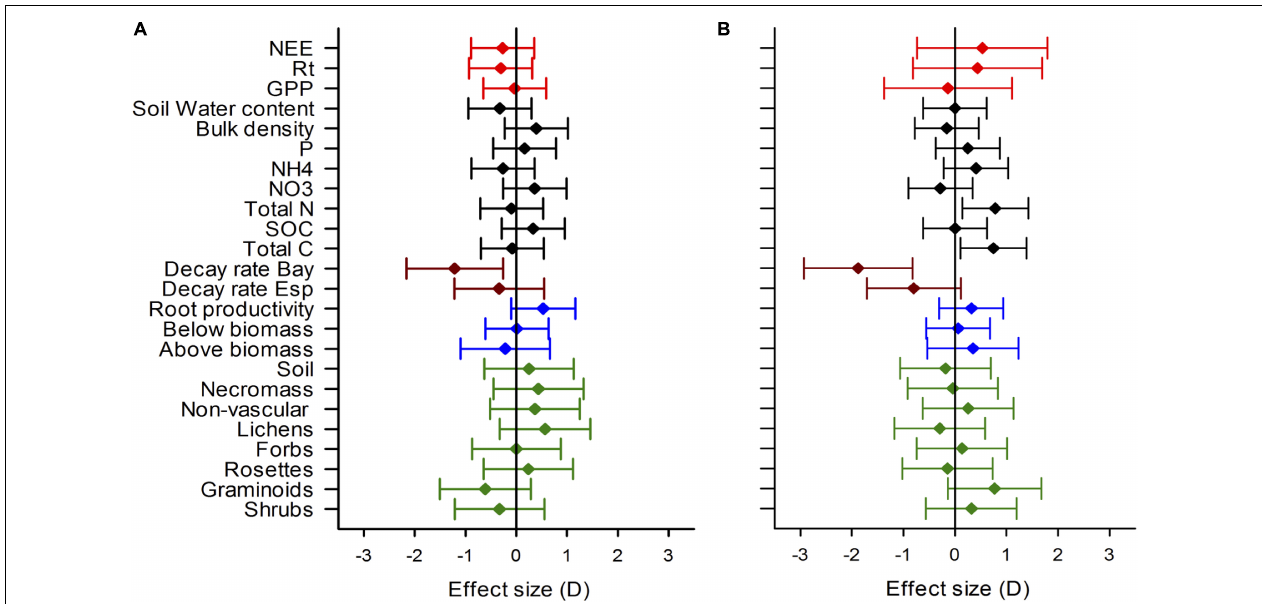
FIGURE 8 | Effects size of experimental warming on CO 2 fluxes (red symbols), soil related properties (black symbols), decomposition rate (brown symbols), productivity and biomass (blue symbols), and on vegetation cover (green symbols) in Matarredonda (A) and Sumapaz (B) . Diamond symbols show the warming effect size and the error lines the 95% CI. When 95% CI do not overlap with zero the warming treatment has a significant effect, positive values indicate a positive effect of warming and negative values a negative effect of warming. The effect size for most variables are for measurements taken in June 2019 after 3 years of the establishments of the experiment, except for decomposition and root productivity that were taken during the first 2 years of warming. Decay rate “Bay” refers to the estimate for Laurus nobilis and decay rate “Esp” for the estimates for Espeletia grandiflora